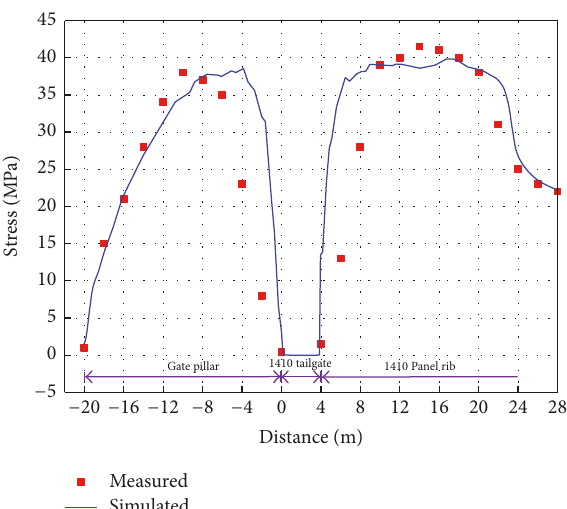
Figure 14: Side abutment stress distribution of numerical simulation and field measurement.